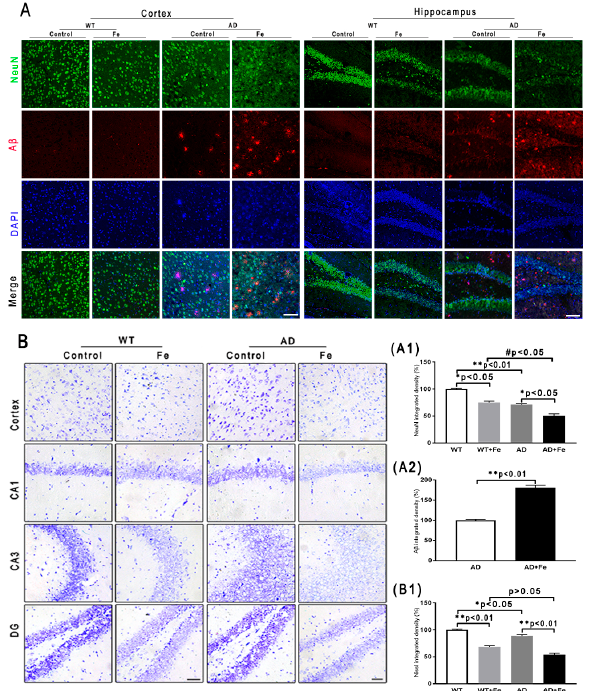
Figure 2. ( A ) Immunofluorescence of A β and NeuN. Scale bar = 25 µ m, ( A1 , A2 ) Quantitative analyses of Neun-positive staining and A β -positive staining. ( B ) Nissl staining in the mouse brain. Scale bar = 25 µ m. ( B1 ) Quantitative analyses of Nissl-positive staining, n = 8. * p < 0.05, ** p < 0.01 compared with the control group; # p < 0.05 compared with the iron-treated WT